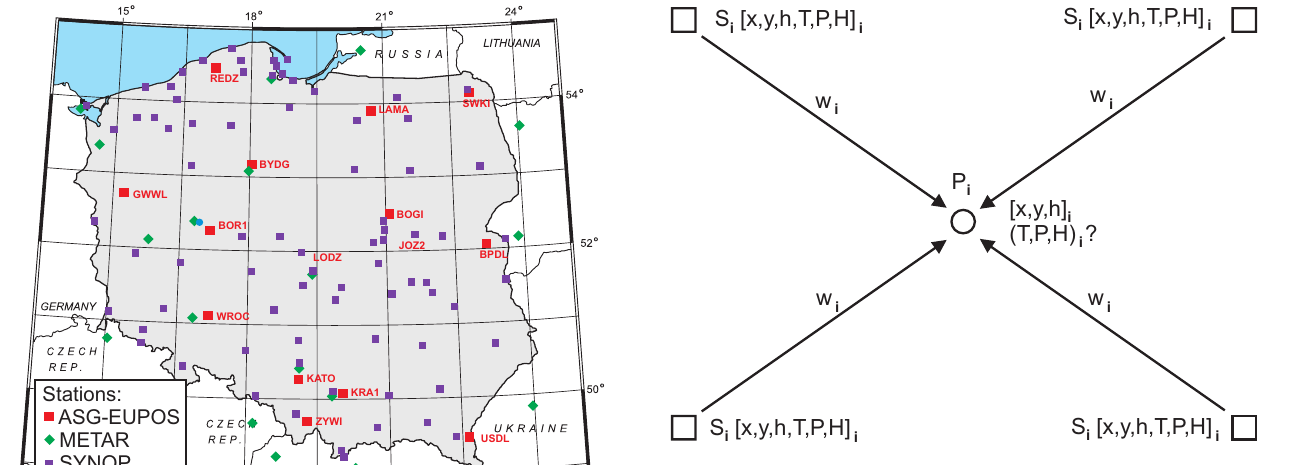
Fig. 3. Interpolation of the atmospheric parameters ( T – tempera- ture, H – relative humidity, P – pressure) from the known meteo- rological stations ( S i ) to a known location ( P i